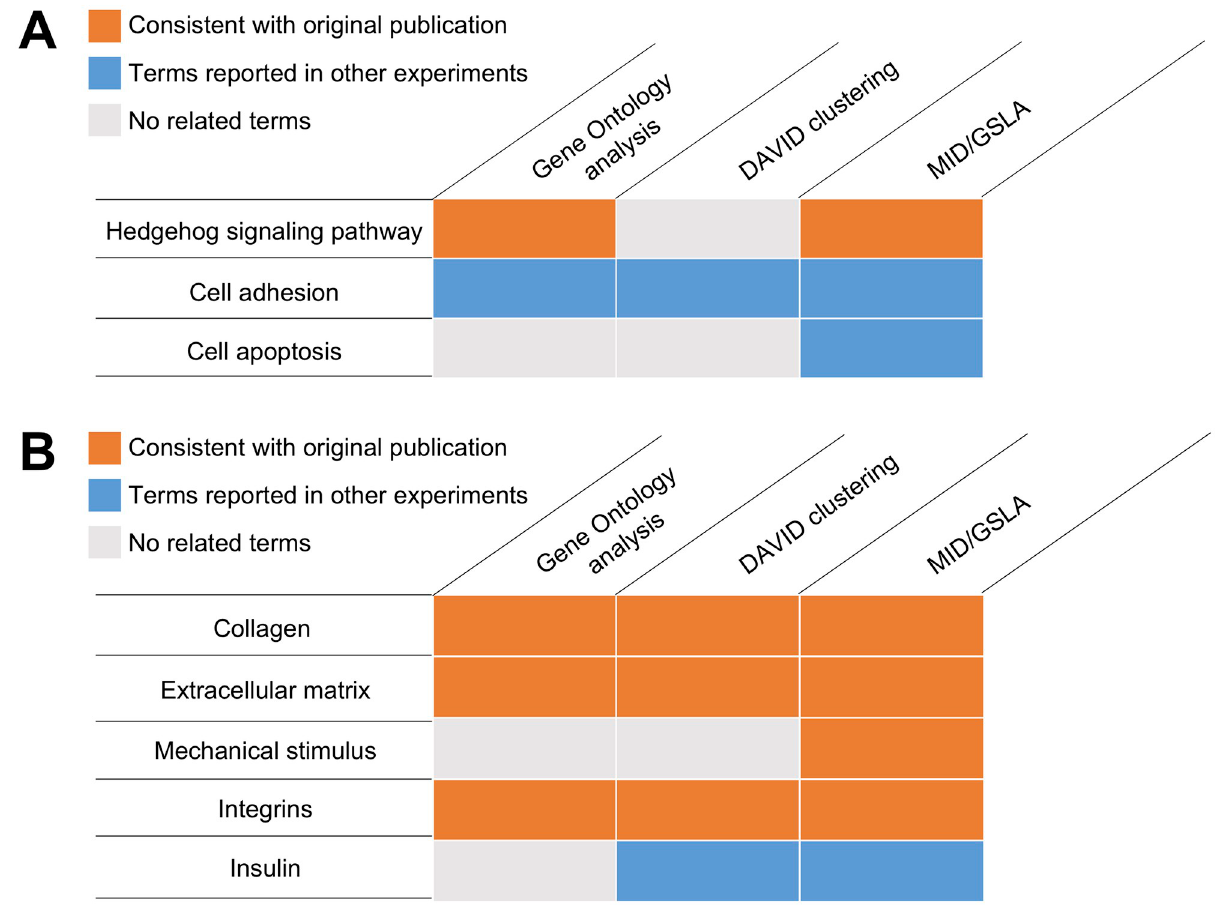
Fig 5. The functional categories of the terms reported by MID/GSLA, DAVID, and PANTHER (GO ontology analysis). The annotations produced by MID/GSLA are more comprehensive and informative for further mechanistic study.